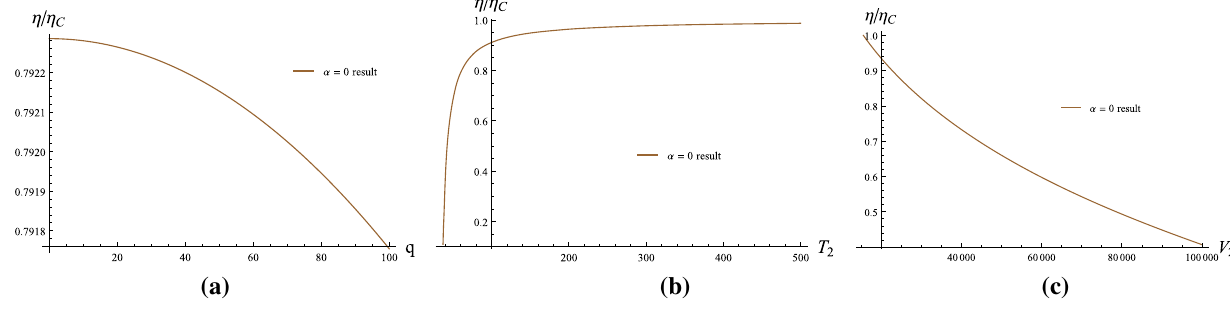
Fig. 4 Effect of parameters on efficiency, when other parameters (see the caption of Fig. 2 for parameter values) are fixed and β = 5